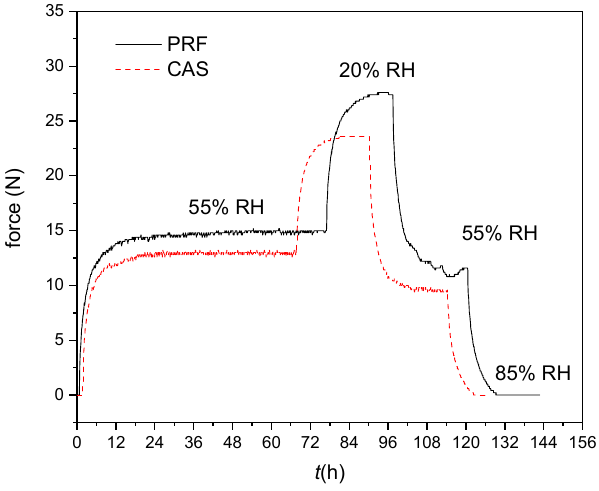
Figure 8. Actuator forces for CAS and PRF bilayers as a function of time and steps of relative hu- midity.